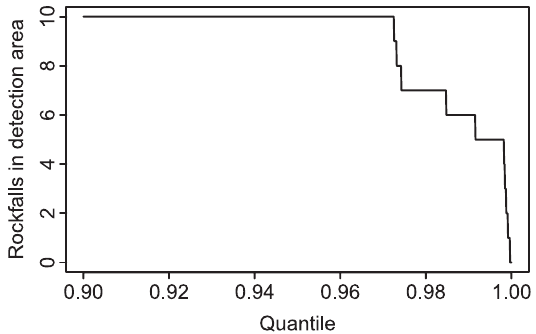
Figure 8. Number of rockfall trajectories inside location estimate polygons as function of minimum location estimate